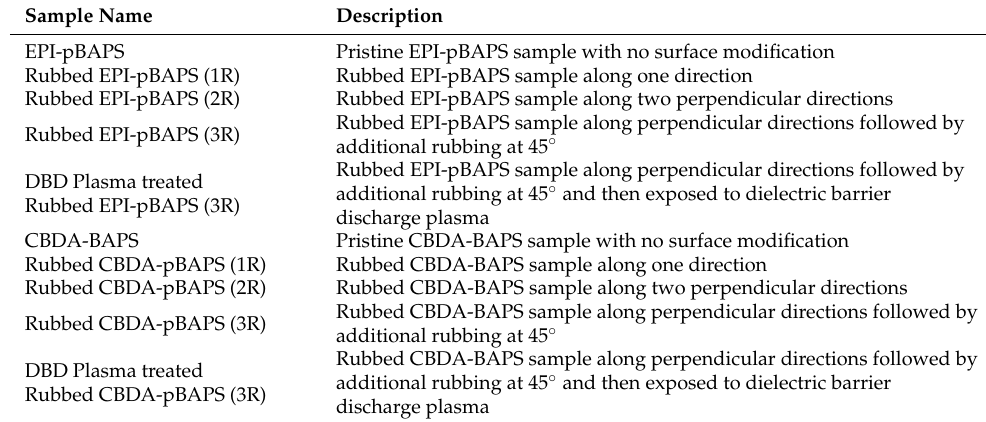
Figure 3. Discharge voltage and current waveforms.